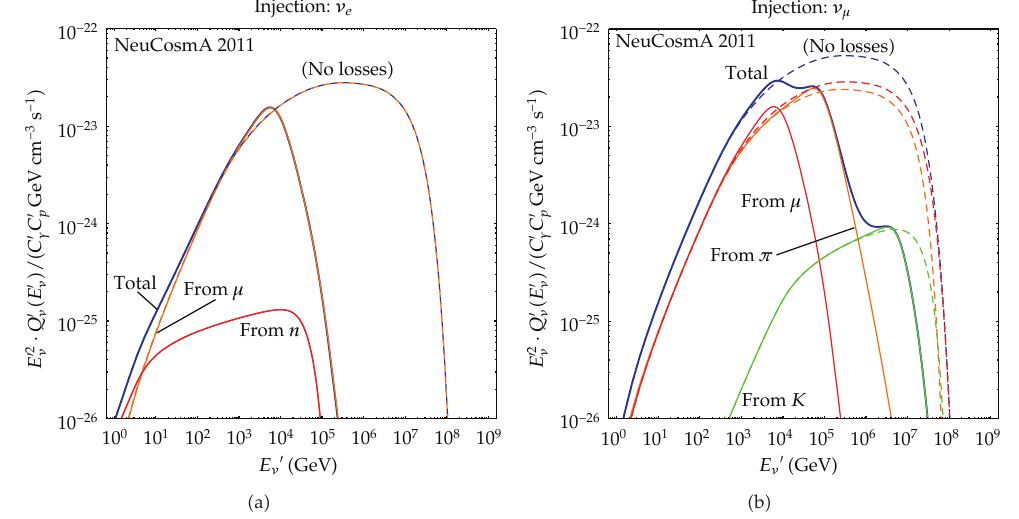
Figure 4: Injection spectra for electron neutrinos (cid:3) a (cid:4) and muon neutrinos (cid:3) b (cid:4) at the source for a GRB example, where the individual contributions from the parents are shown (cid:3) neutrinos and antineutrinos added (cid:4) , figure taken from (cid:5) 30 (cid:6)